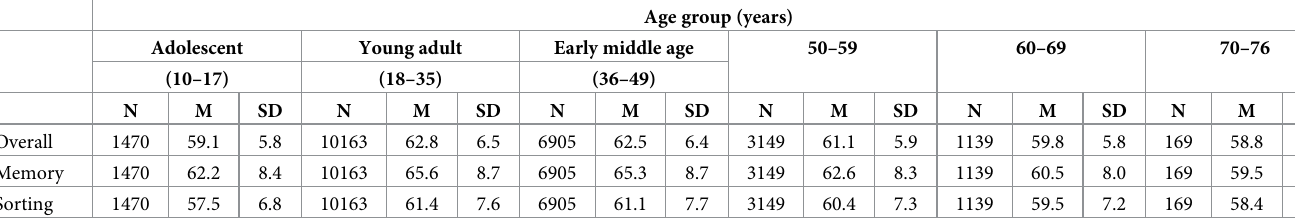
Table 4. Mean accuracy (%) and standard deviation by participant age from online samples.